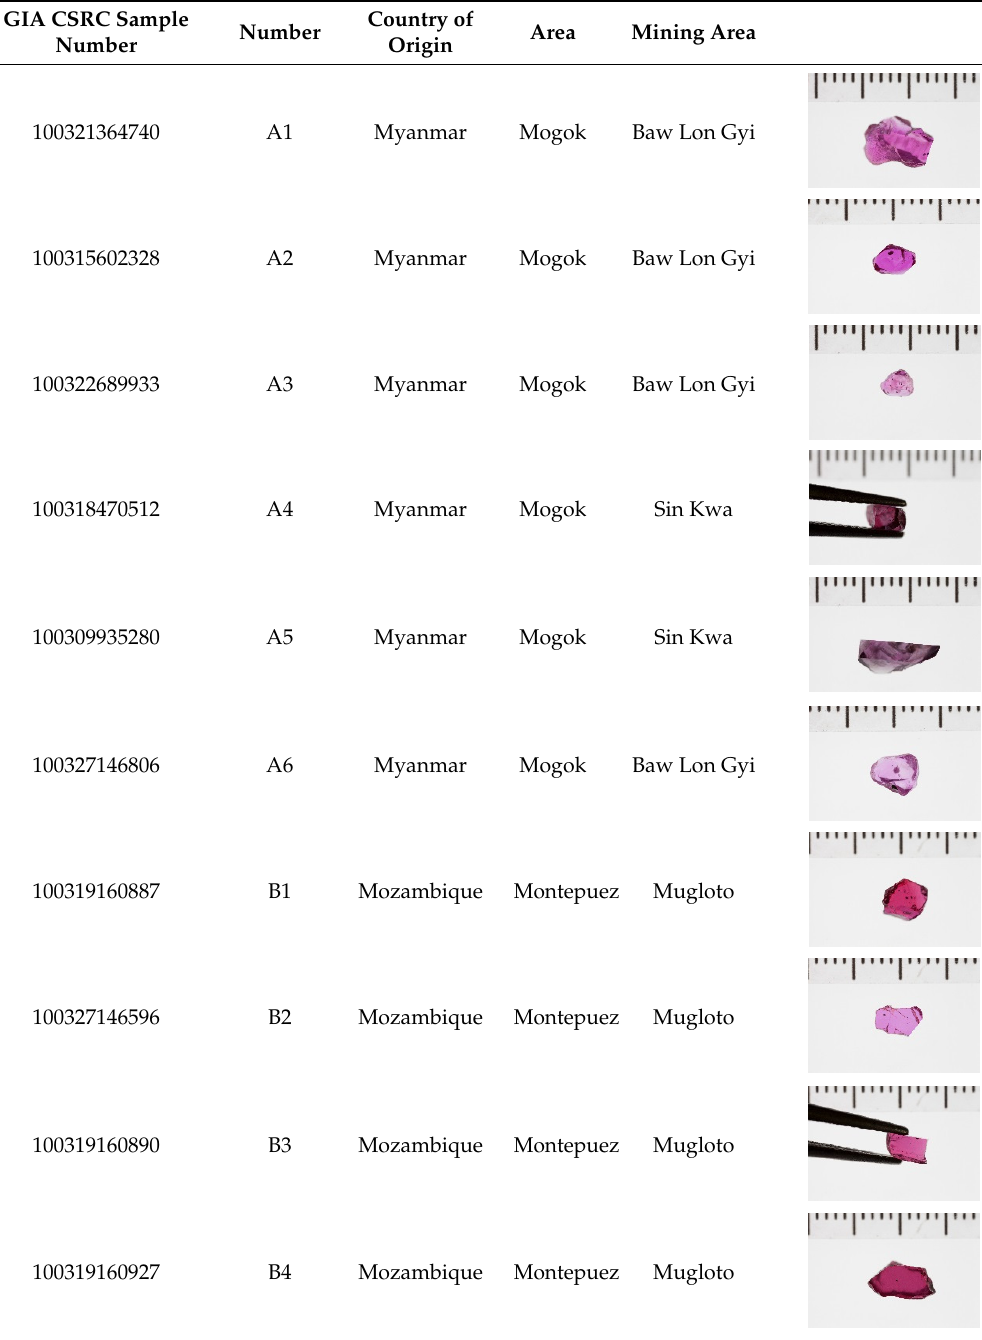
Table 1. Samples used during this Table 1. Samples used during this study. Table 1. Samples used during this study. Table 1. Samples used during this study. Table 1. Samples used during this study. Table 1. Samples used during this study. Table 1. Samples used during this study. Table 1. Samples used during this study. Table 1. Samples used during this study. Table 1. Samples used during this study. Table 1. Samples used during this study.